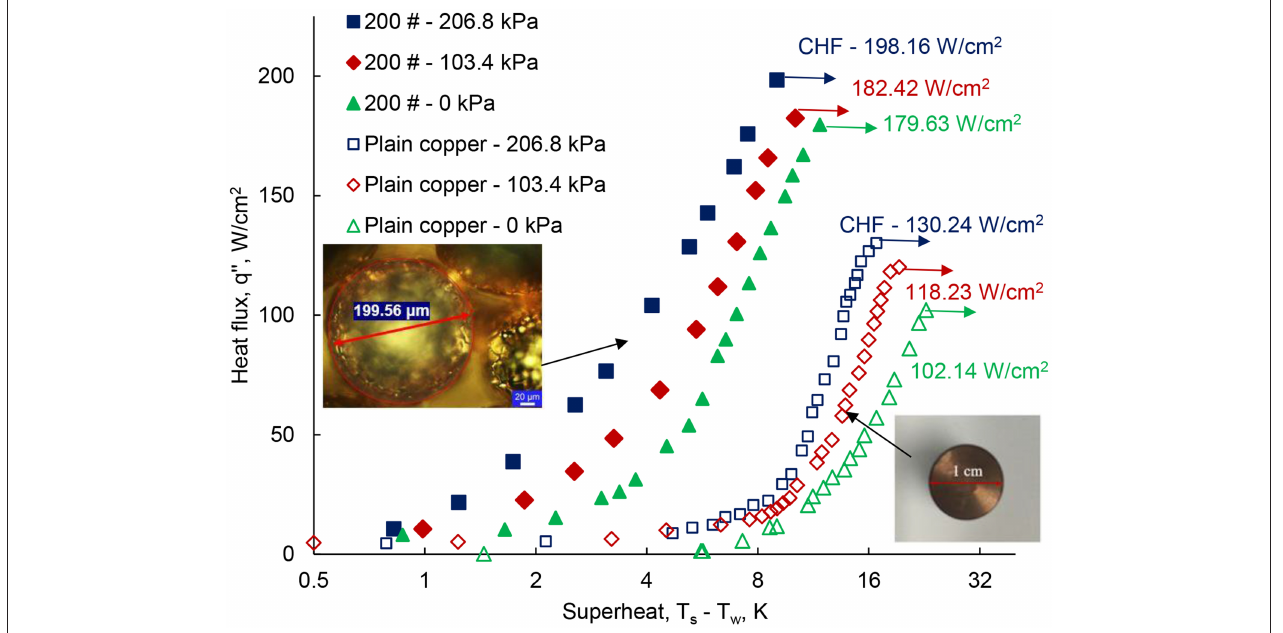
FIGURE 5 | The high-pressure pool-boiling curves for plain surface and 200 µ m single-layer wick surface for three different gauge pressures; 0, 103.4, and 206.8 kPa. The critical heat flux for each condition is reported for the plain copper and the wick